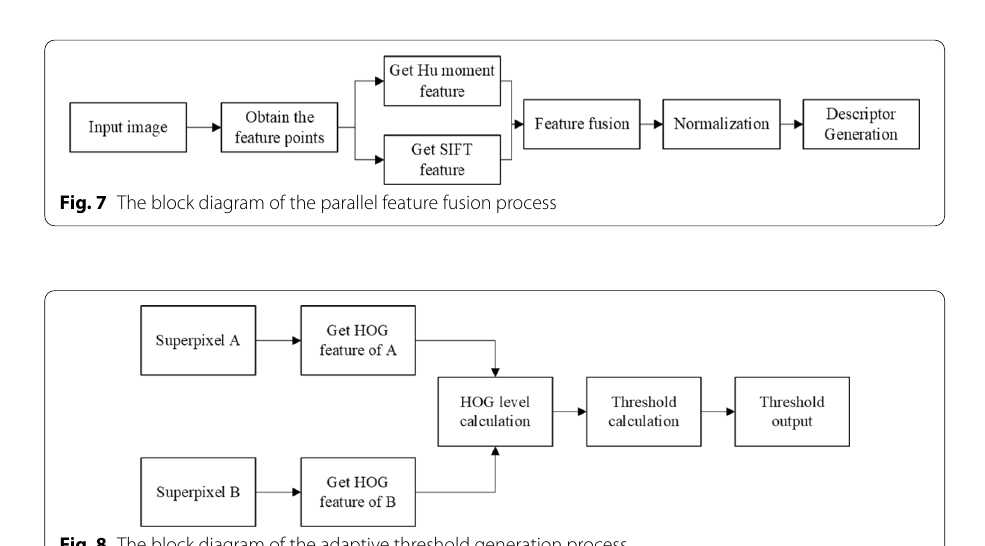
Fig. 8 The block diagram of the adaptive threshold generation